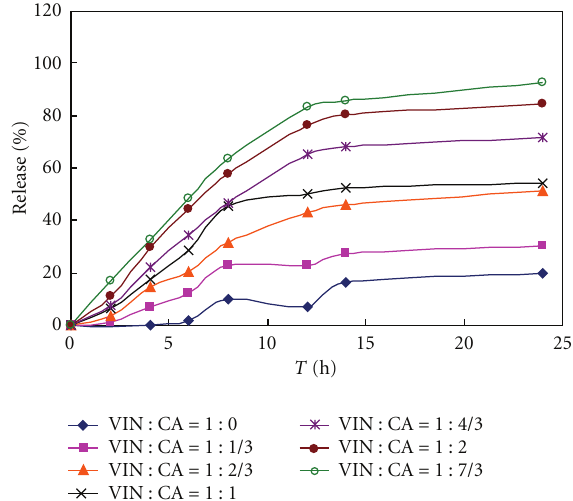
Figure 3: Formulation with di ff erent molar ratio citric acid and vinpocetine dissolution profile (core tablets in 0.5% SDS dissolution media); VIN: vinpocetine; CA: citric acid.